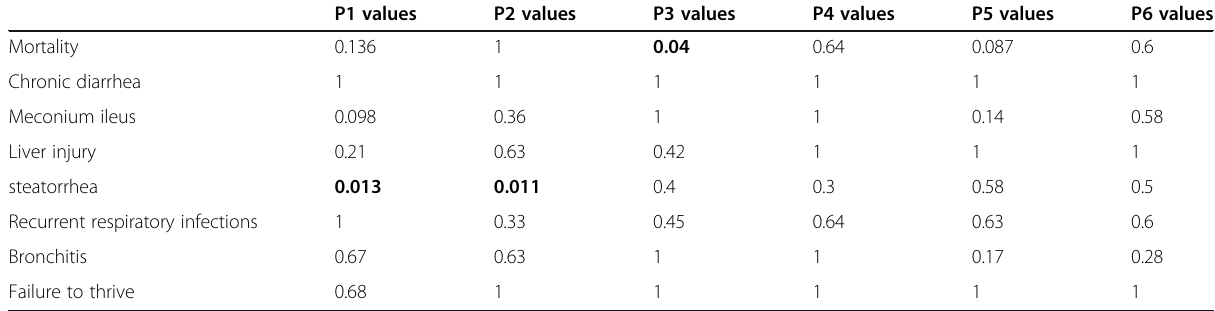
Table 7 P values of the comparison groups to determine the relationship between the incidence of different clinical